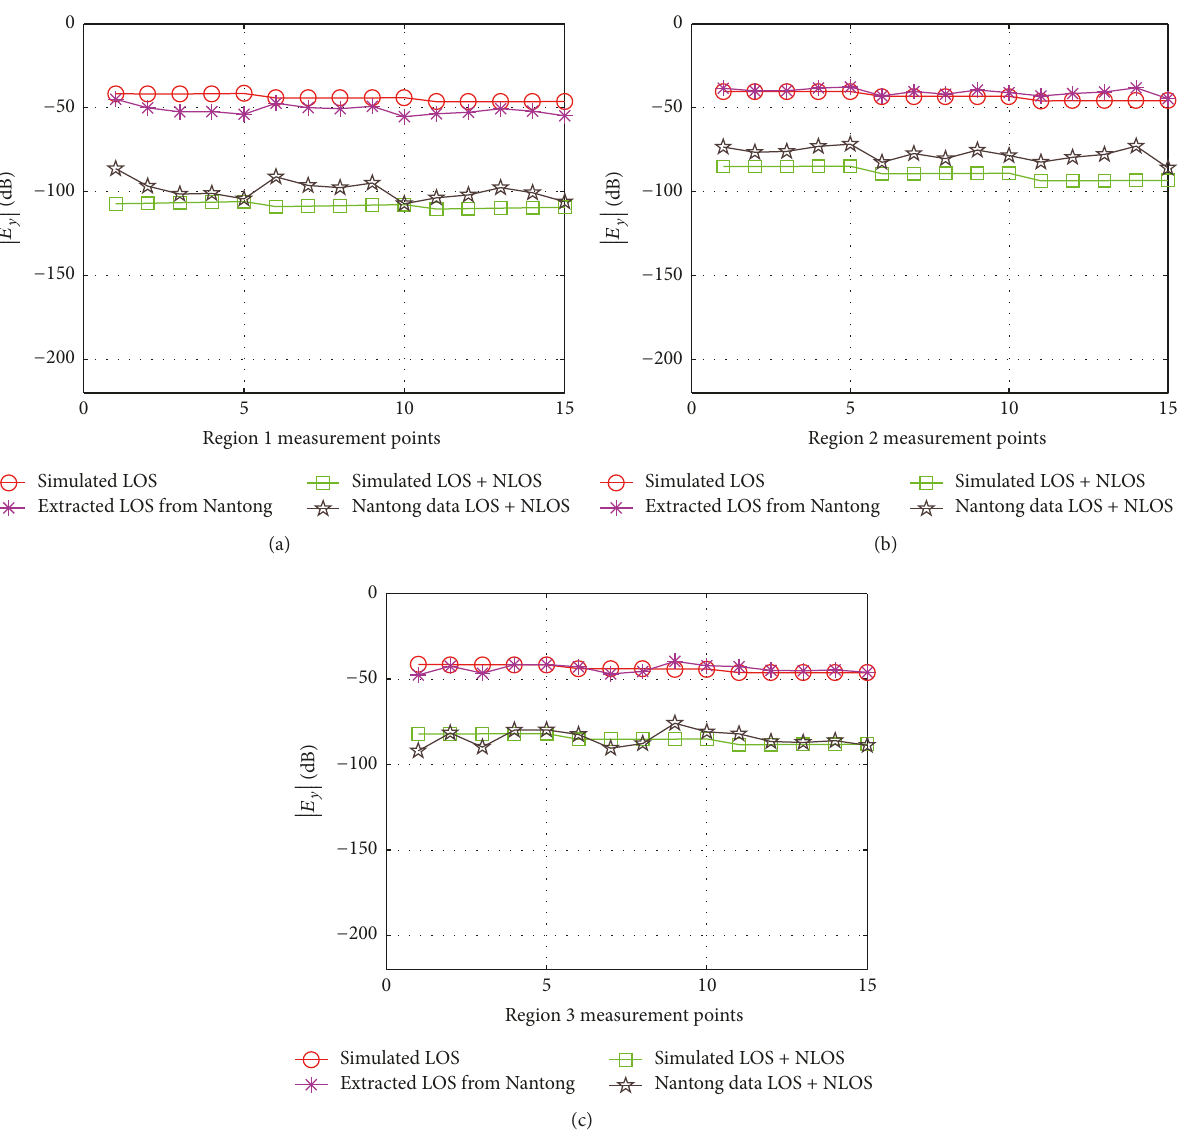
Figure 7: The distribution of 𝐸 𝑦 of vertically polarized LCX for the LOS and NLOS paths and its comparison with the Nantong Tunnel different measuring locations such as in (a) Region 1, (b) Region 2, and (c) Region 3,